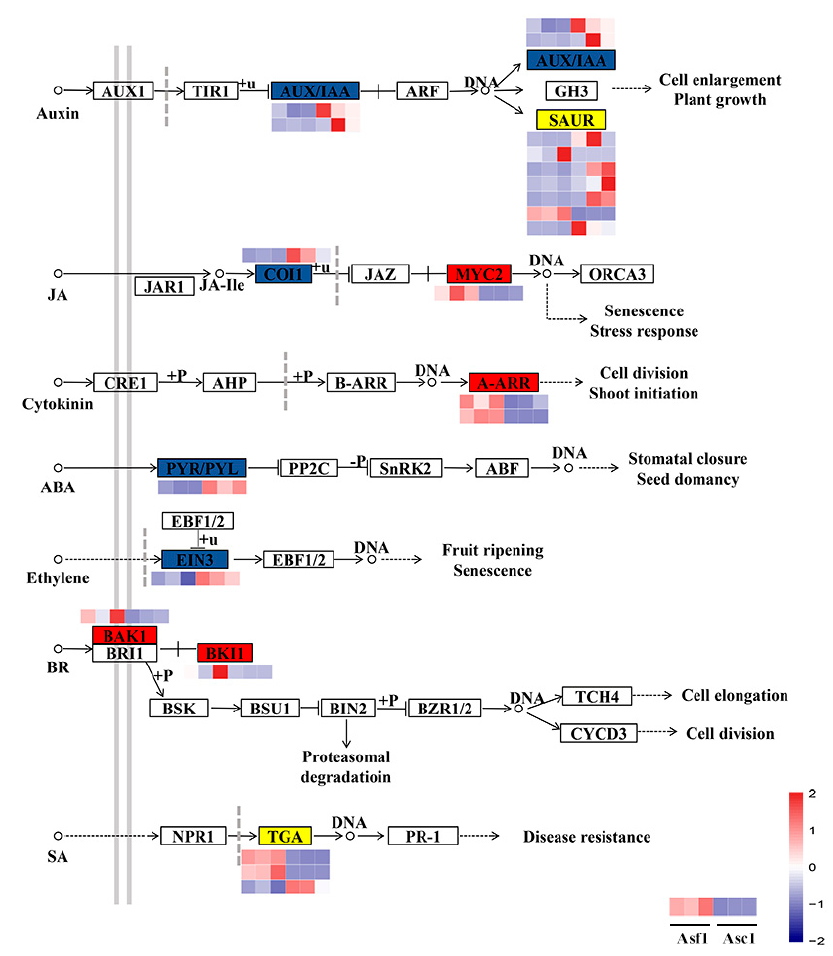
Figure 3. Expression profiling of the DEGs in the hormone signal transduction pathway. The boxes of up-regulated DEGs are marked in red, the down-regulated DEGs are marked in blue, and both are marked in yellow. The expression levels of the related DEGs are shown in the heatmap beside the boxes. Each row represents each DEG, and each column represents the expression level from different samples. The color from blue to red represents gene expression from low to high.